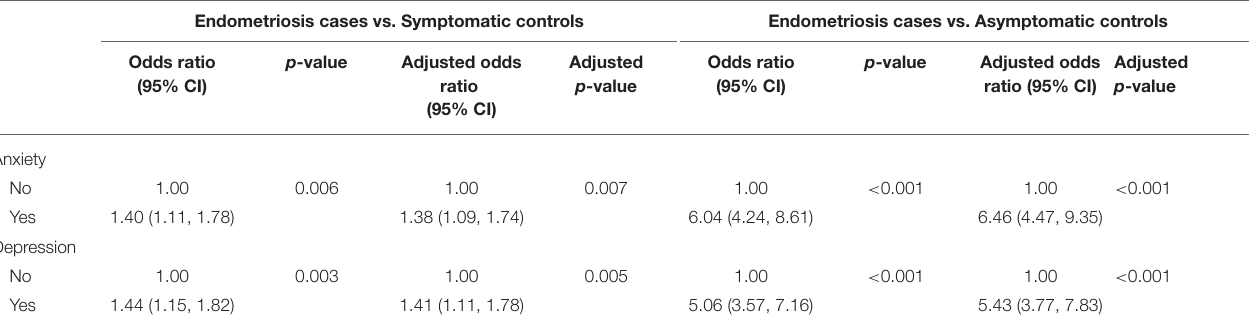
TABLE 5 | Anxiety and depression in women with endometriosis vs. symptomatic controls and asymptomatic controls. Endometriosis cases vs. Symptomatic controls Endometriosis cases vs. Asymptomatic controls